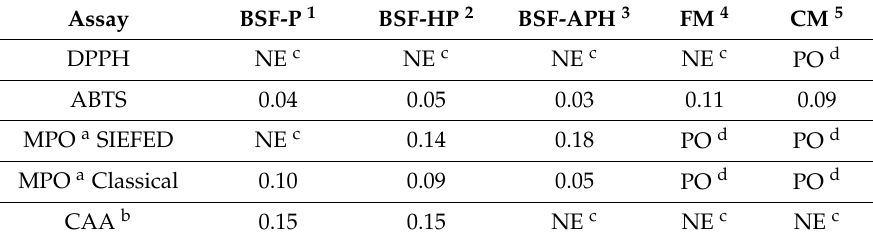
Table 5. Antioxidant activity E max (% inhibition) of samples obtained using different assays. ABTS: